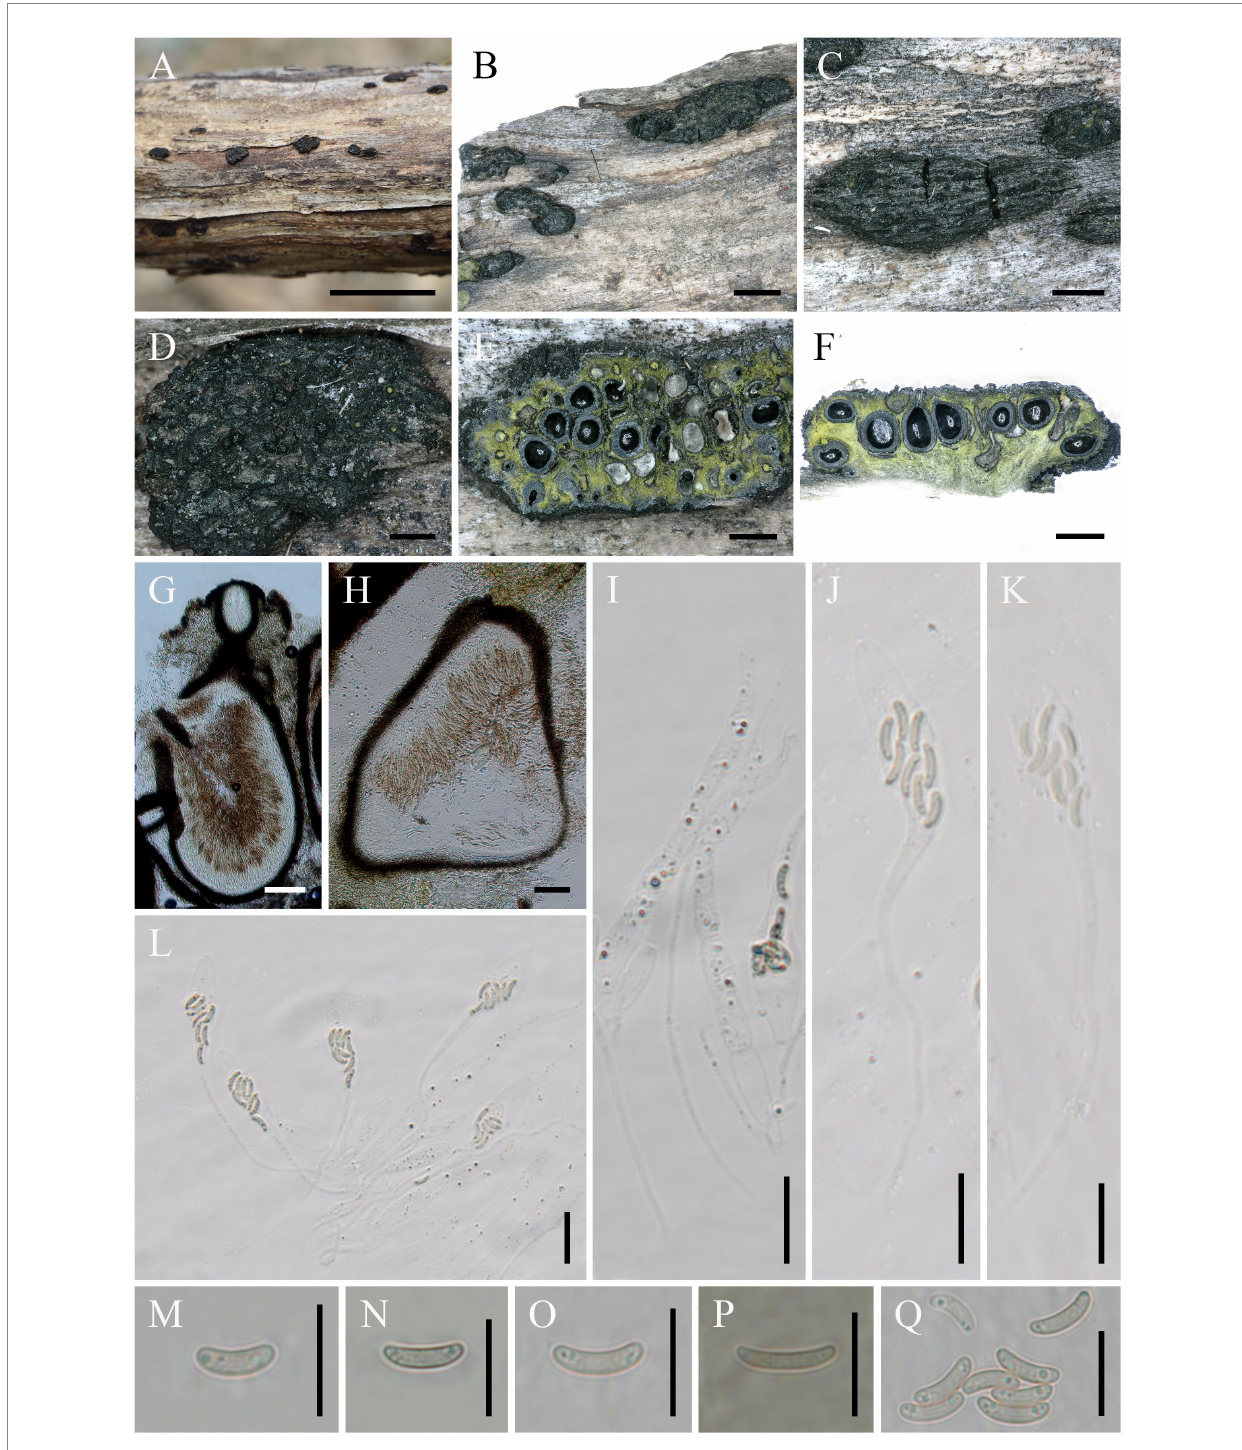
FIGURE 2 Alloeutypa milinensis (FCATAS 4309, Holotype). (A–D) Stromata on substrate. (E) Cross section of a stroma. (F,G) Vertical section through stroma showing ostiole and perithecia. (H) Peridium. (I) Paraphyses. (J–L) Asci. (M–Q) Ascospores. Scale bars: (A) = 15 mm; (B) = 2 mm; (C) = 1 mm; (D–F) = 500 μ m; (G,H) = 100 μ m; (I–L) = 20 μ m; (M–Q) = 10 μ